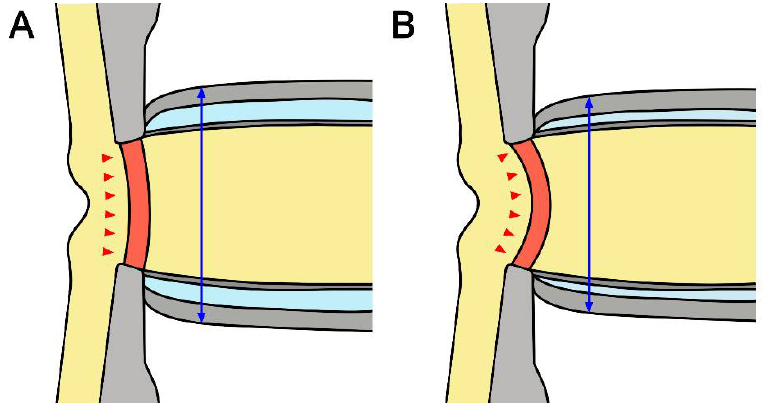
Figure 4. Schematic diagram of the optic nerve in healthy ( A ) and glaucomatous ( B ) eyes. Note that smaller ONSD and more posteriorly curved LC in NTG suggested that low cerebrospinal fluid pressure may induce a relatively higher TLPG in NTG than in healthy eyes. The double headed blue arrows indicate ONSD and the red arrows represent the morphology of LC.